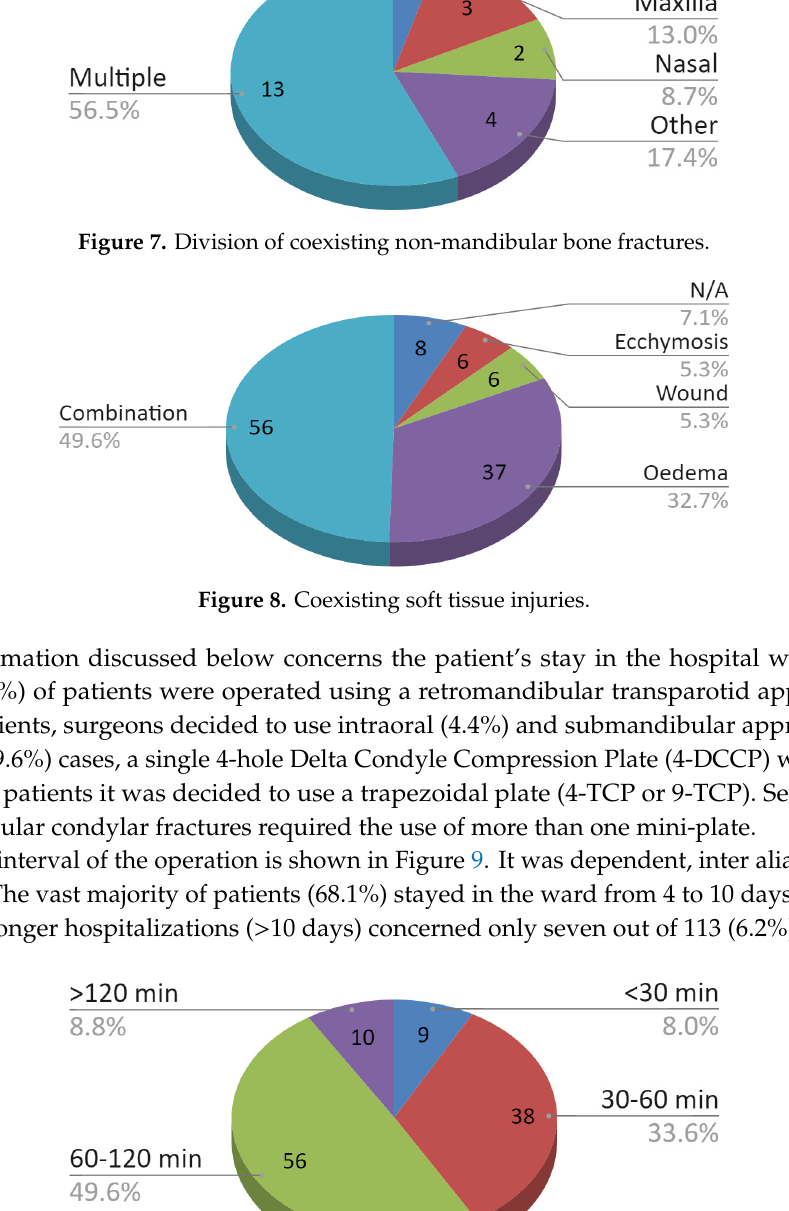
Figure 7. Division of coexisting non ‐ mandibular bone fractures.